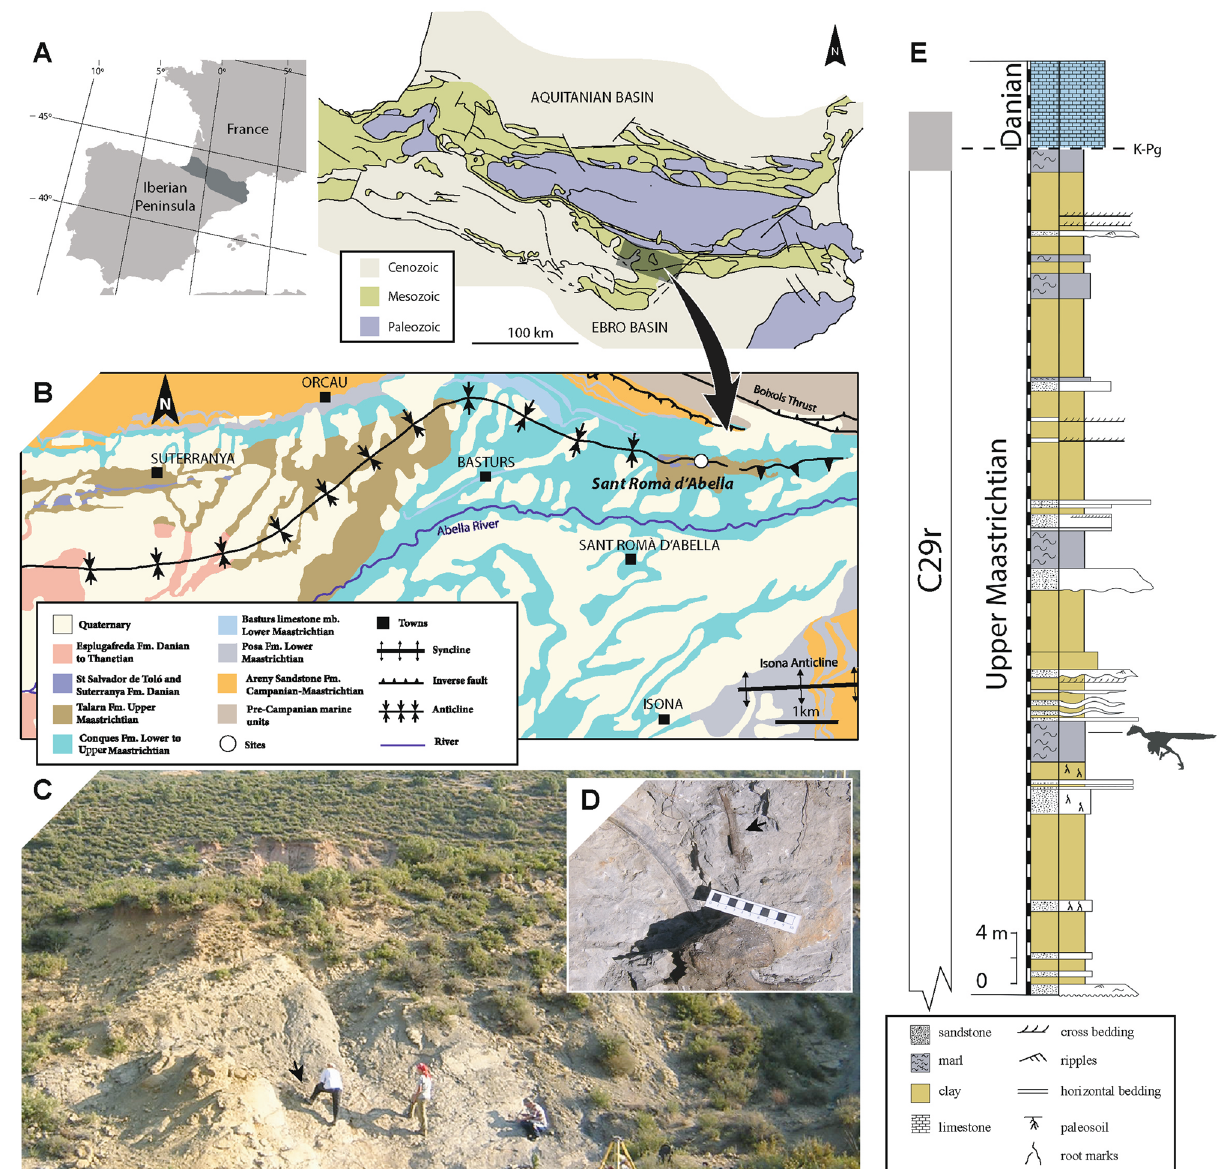
Figure 1. Geographic and geological location of Sant Romà d’Abella site. Geographic location of the Tremp Syncline in the southern Pyrenean region ( A ). Geological map of the eastern part of the Tremp Syncline with the location of the Sant Romà d’Abella site ( B ). Landscape view of the fossil site ( C ) with a detailed picture showing the close spatial relationship between the troodontid metatarsal (MCD-7073) and axial elements of Pararhabdodon isonensis ( D ). Stratigraphic section at Sant Romà d’Abella area with the precise position of the fossiliferous Sant Romà d’Abella site ( E